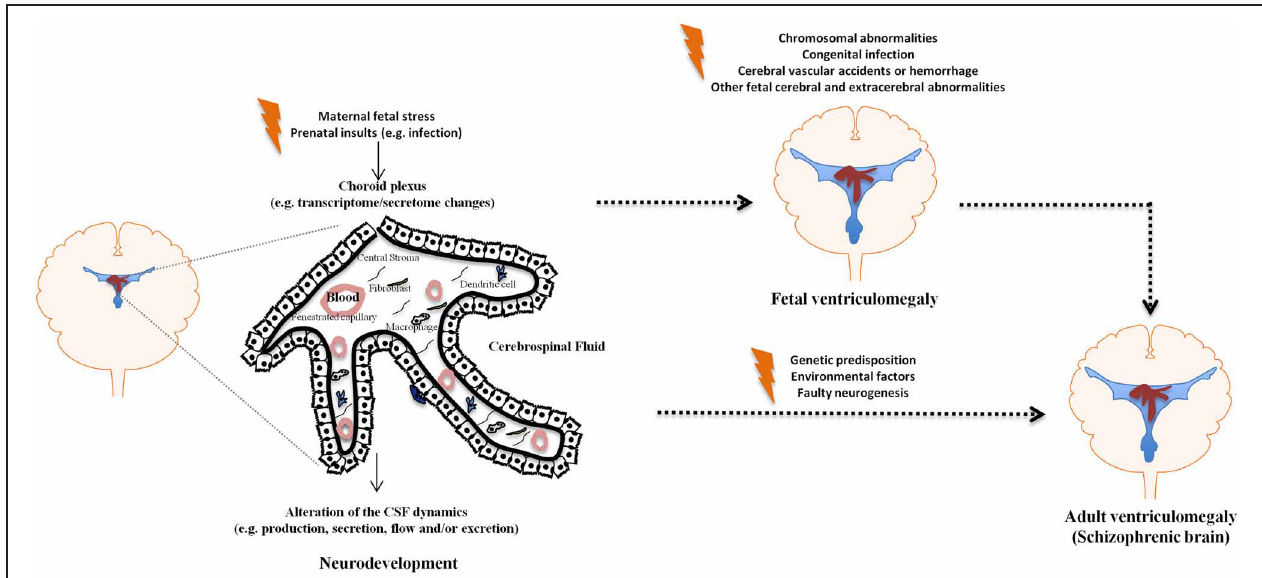
FIGURE 1 | The choroid plexus/CSF nexus in ventriculomegaly. The figure depicts schematically how various insults may influence the CP/CSF homeostasis during development and in the adult brain, resulting in